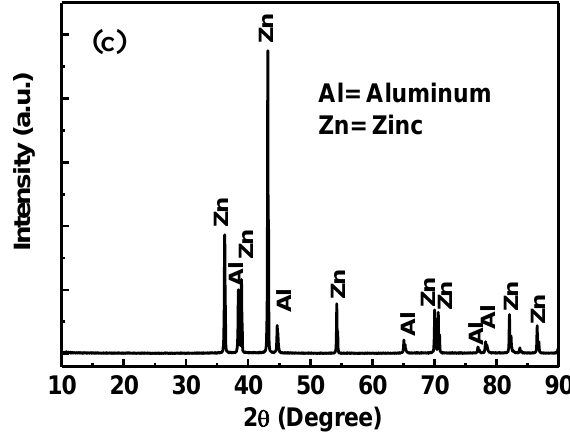
Figure 4. ( a ) SEM of top surface, ( b ) SEM of cross section, and ( c ) XRD of Zn–Al coating.